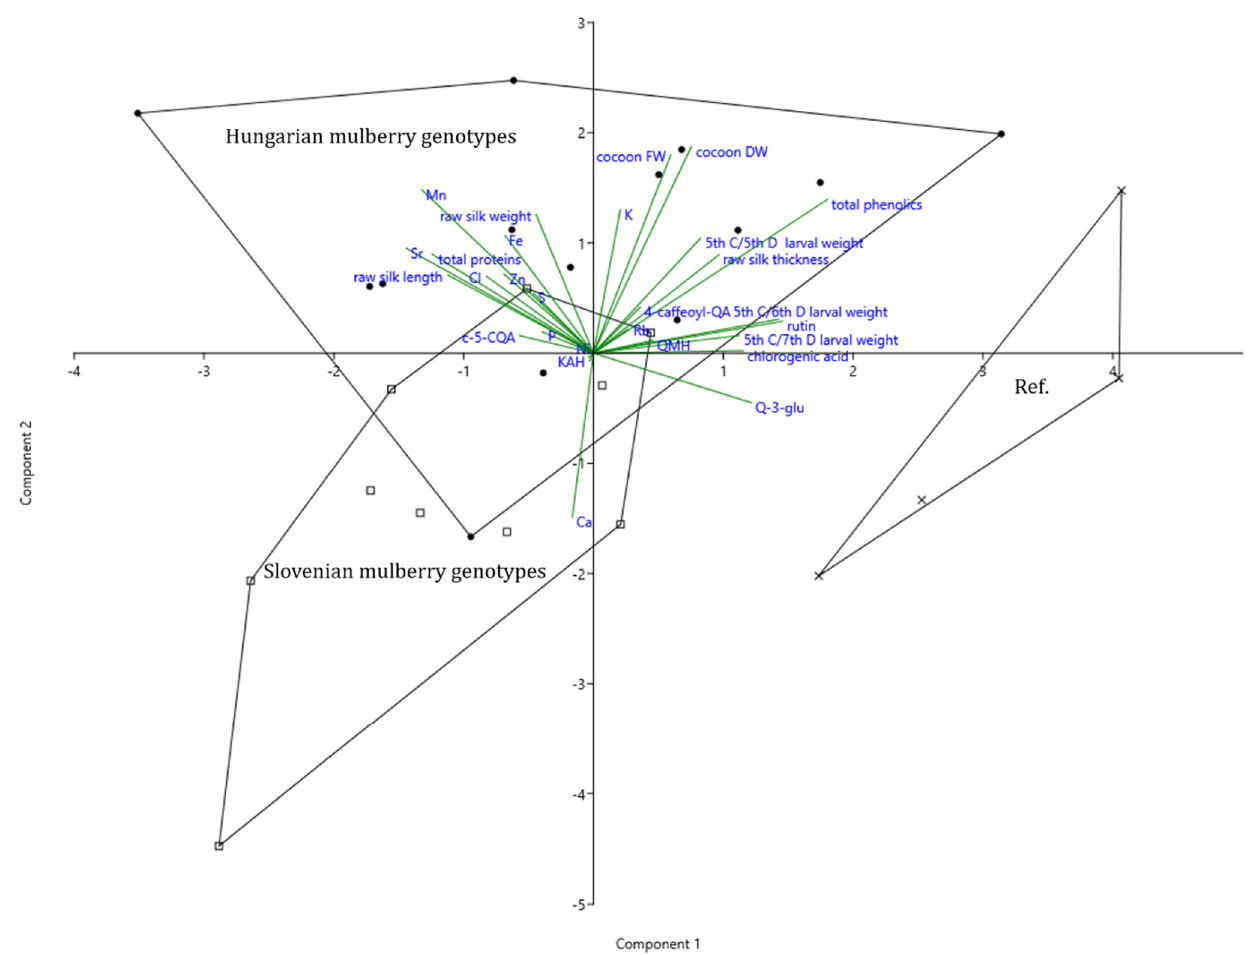
Figure 4. Principal component analysis of silkworm, cocoon, and raw silk parameters along with the chemical composition of leaves of different origins. The convex hulls delimit the space that includes the samples of mulberry trees from different Slovenian regions (squares), Hungarian regions (dots) compared to traditional high yielded sericultural varieties (Ref, crosses). * 4-caffeoyl-QA, 4-caffeoylquinnic acid; c-5-CQA, c-5-coumaroylquinnic a.; Q-3-glu, quercetin-3-glucoside; QMH, quercetin malonyl hex; KAH, kaemph acetyl-hexoside.